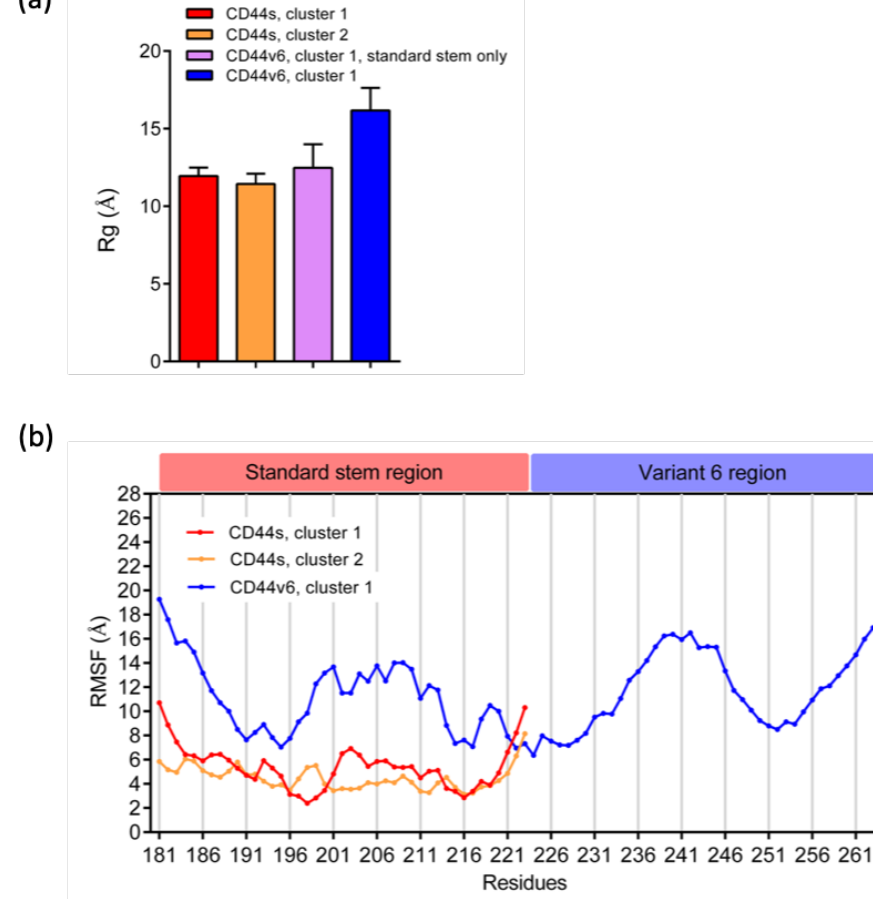
Figure 4. Analysis of ( a ) the radius of gyration (Rg) and ( b ) the root mean square fluctuation (RMSF) for the C α atoms of the most populated for the Cα atoms of the most populated clusters.